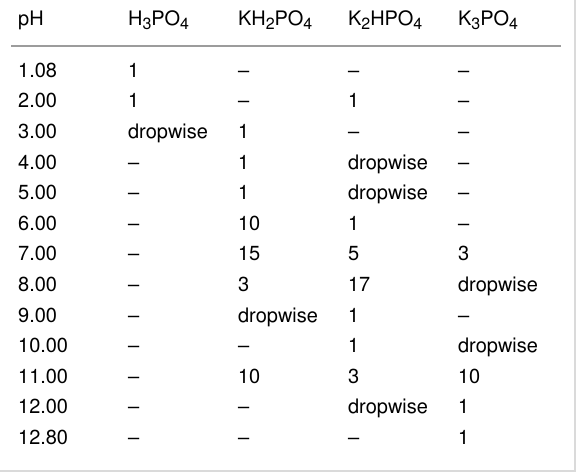
Table 2: Ratios of 0.1 M aqueous phosphates solutions used to prepare buffers of the specified pH.